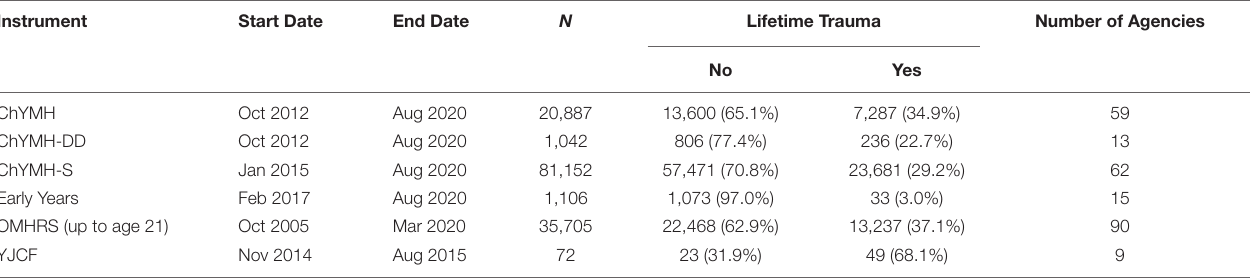
For Figure 4 , individuals with two consecutive assessments (ChYMH or ChYMH-DD or ChYMH-Screener) between 30 and 365